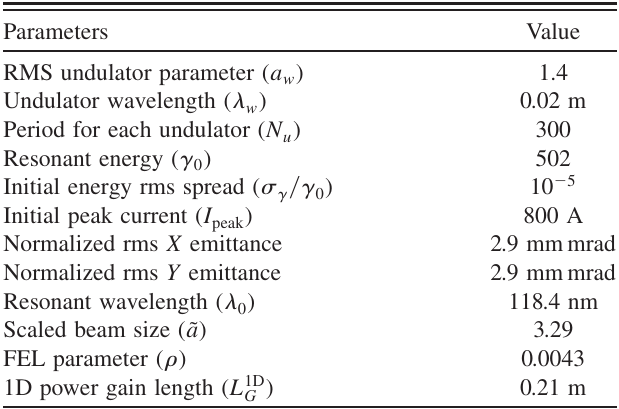
TABLE I. Parameters for